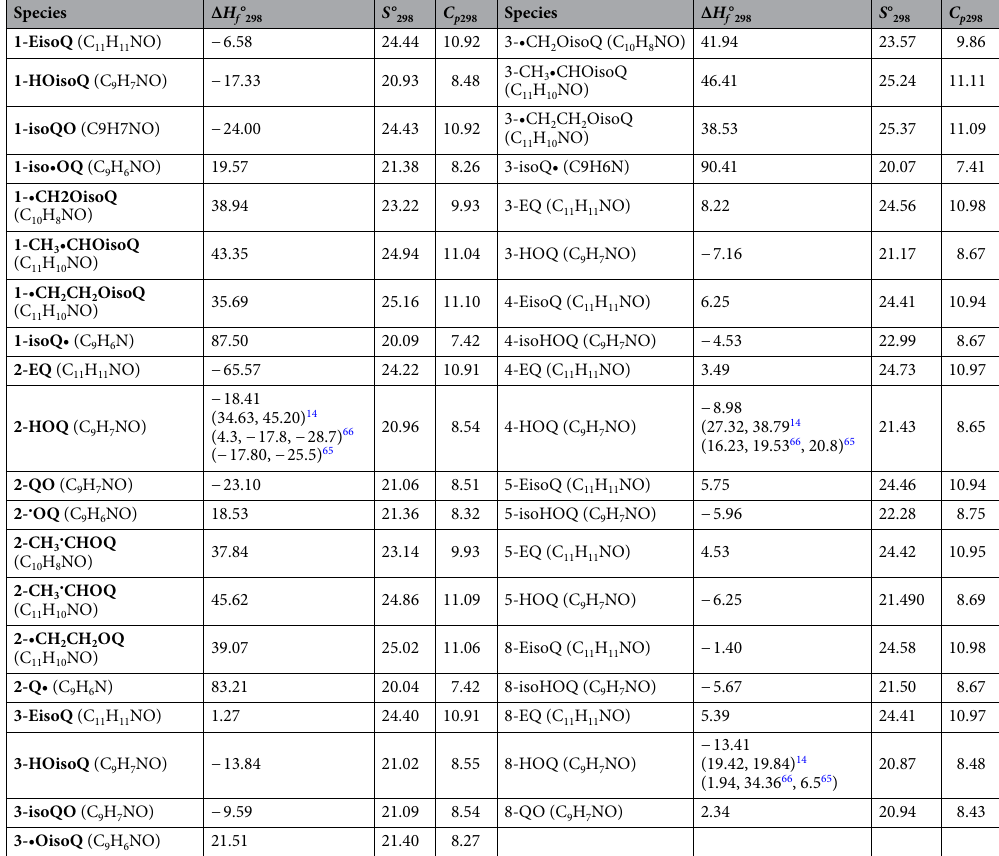
Table 1. Calculated Δ H f ° 298 (in kcal mol −1 ), S ° 298 (cal mol −1 K −1 ), and C p 298 (cal mol −1 K −1 ) at CBS-QB3// BMK/6–31+G(d,p)